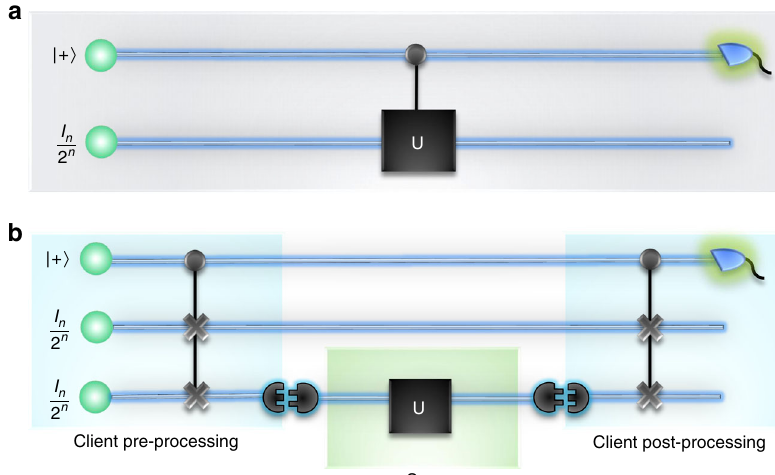
Fig. 1 The DQC1 and modular DQC1 algorithms. a The standard DQC1 algorithm operates by applying U on an n -qubit register controlled by a pure qubit initialized in state jþi . T ð U Þ can then be estimated through appropriate measurements on the control qubit. This algorithm cannot leverage a third party to implement U as it is impossible to add a control to an unknown unitary 11 . b The modular DQC1 algorithm evaluates j T ð U Þj in a way in which U can be out- sourced to a third party. Here, Alice introduces a second n -qubit register. She then sends the server one of the n -qubit registers via a speci fi ed interface (this could be the original register, or involve fi rst mapping the register into a medium suitable for communication via a SWAP gate). On the proviso